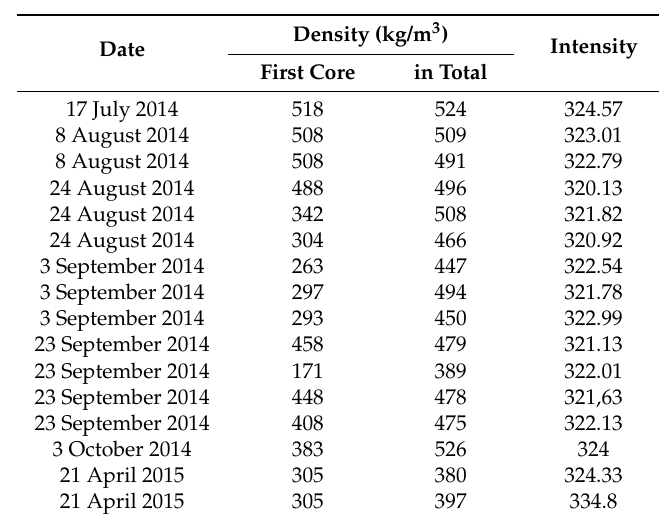
Table 5. Date, density and intensity of each snow pit. Based on these numbers, the correlation coefficients were